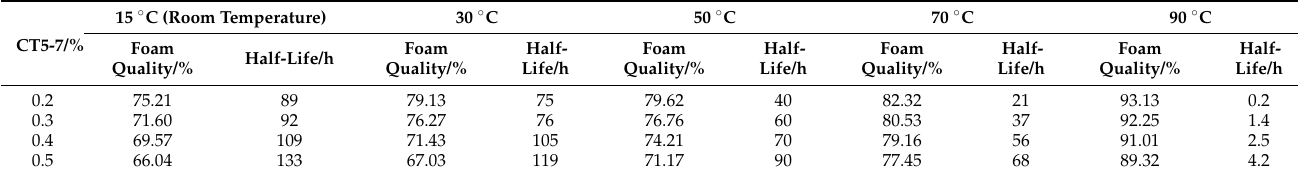
Table 5. The half-life of foam in gel fracturing fluid at different temperatures.